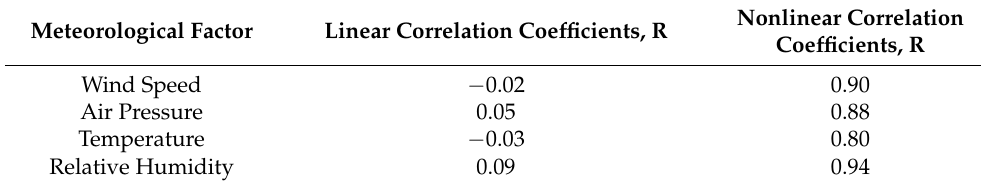
Table 2. Correlations between AOD and meteorological factors in the wet season. Meteorological Factor